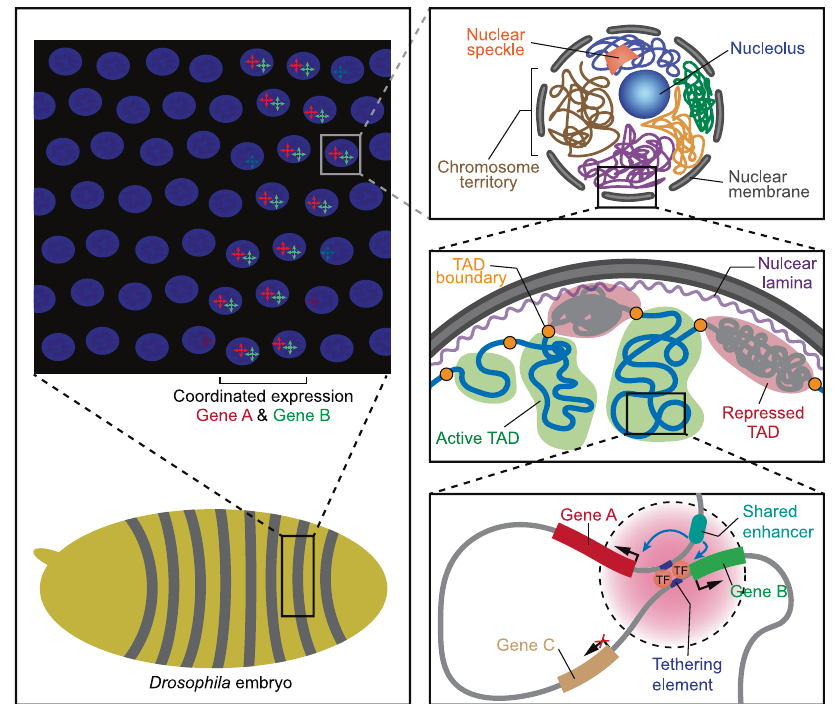
Fig. 1 Topological operons for transcriptional coupling. Functionally linked paralogous genes are expressed in a co-dependent manner during embryonic development. Levo et al. have discovered that distant genes engaged in a common process are physically brought together in three-dimensional space by specialized genomic regulatory sequences called promoter-proximal tethering elements. This long-range interconnection between paralogous genes mediates the formation of co-transcriptional hubs and supports their coordinated expression required for the establishment of developmental